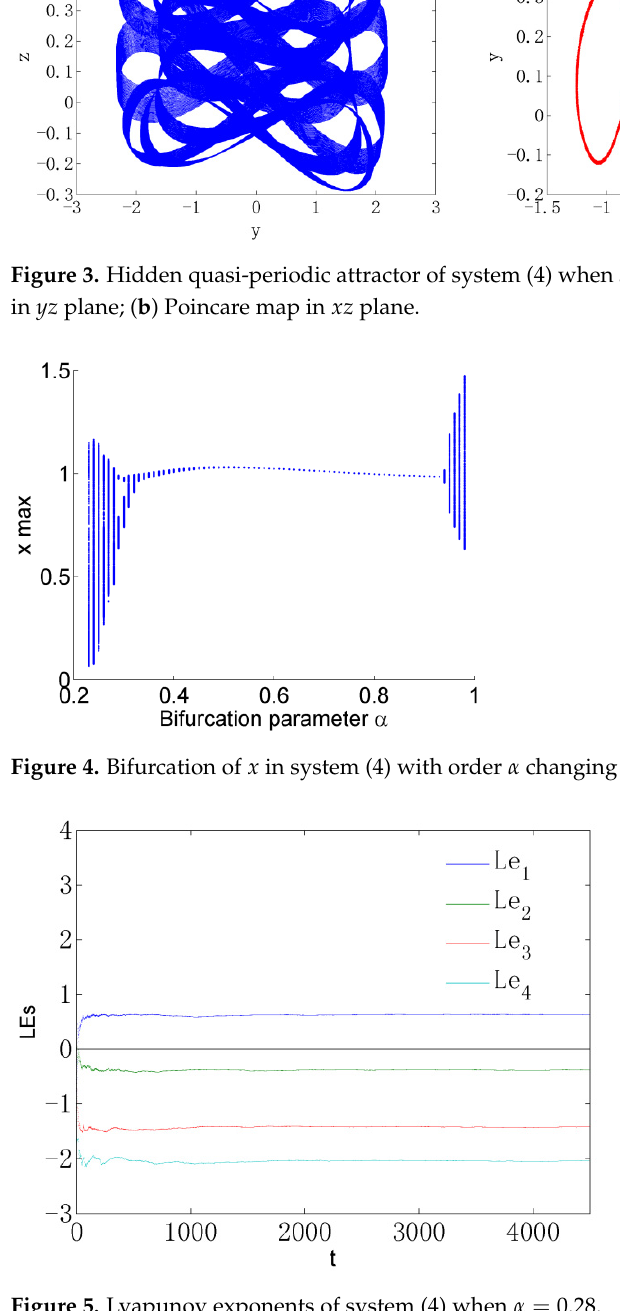
Figure 5. Lyapunov exponents of system (4) when α = 0.28. Select a = 1, b = 0.1, µ = 0.5, ω = 2.01, initial value (0, 2, 0, 0), fixed α = 0.95, nu-